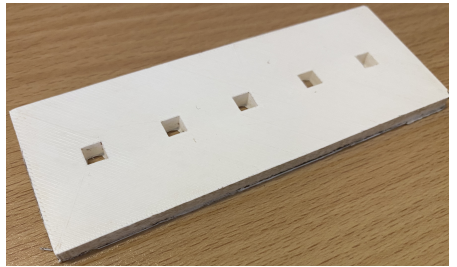
Figure 1. Photograph of the 3D-printed PMMA mold used to fabricate the implant